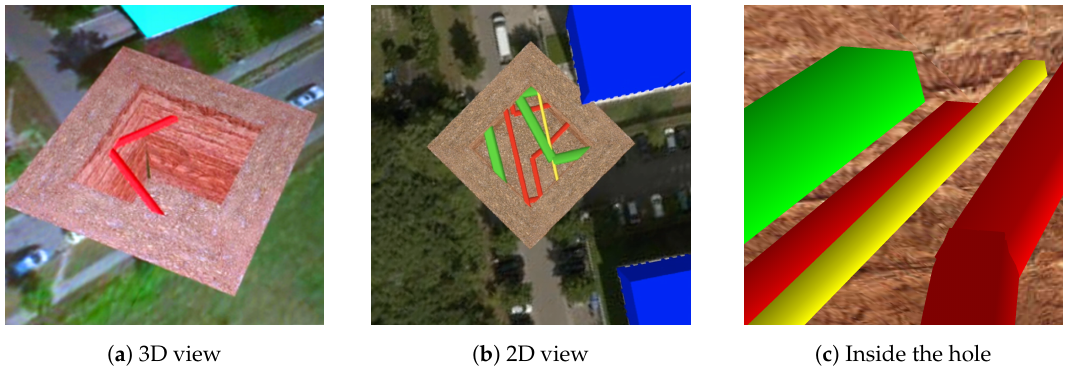
Figure 11. Underground network visualization using the excavator tool extension [3] for virtual